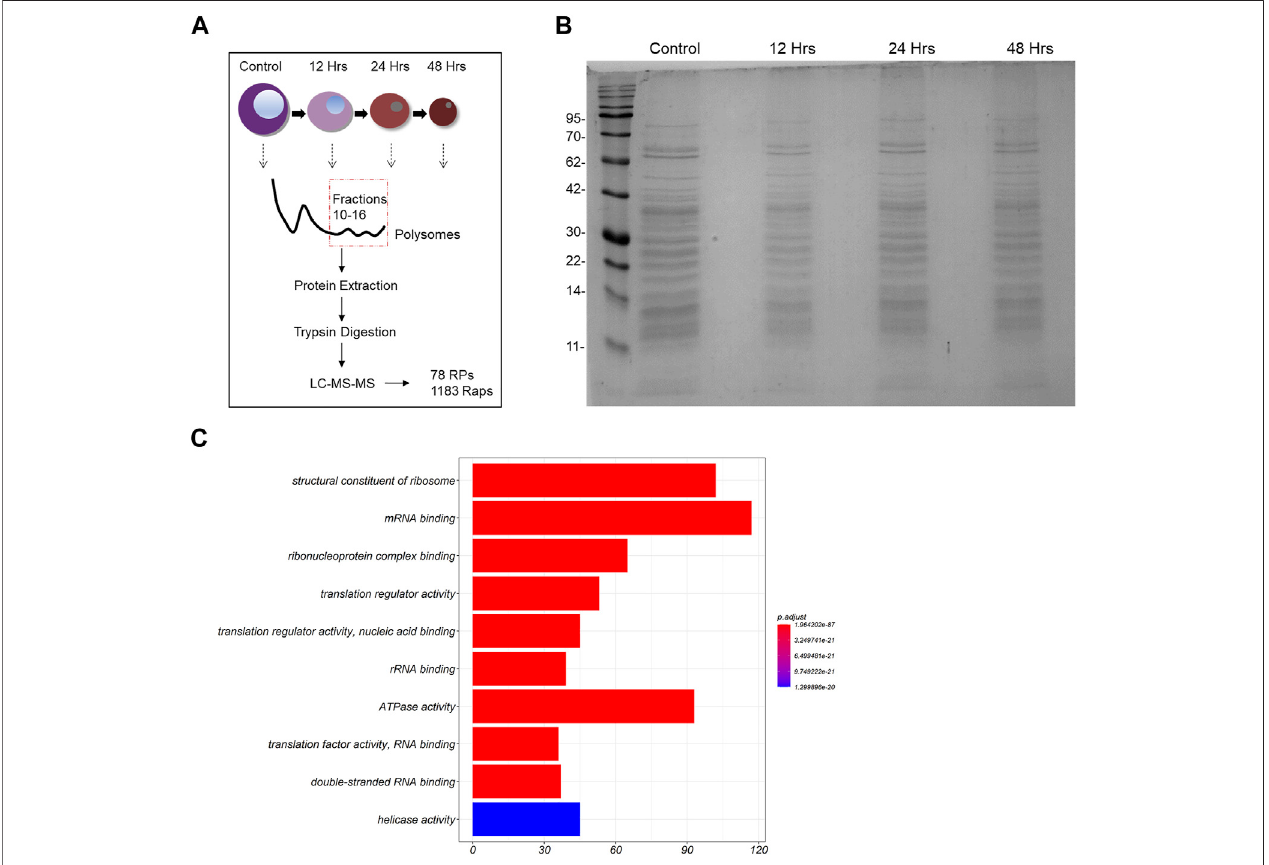
FIGURE 2 | Analysis of the riboproteome in MEL cells. (A) Design of the study. (B) Total protein material was extracted from pooled fractions 10 – 16 by protein fi ltration. The proteins were then loaded on an SDS-PAGE gel, stained with blue silver staining and depicted. (C) Gene ontology (GO) Molecular Function (MF) terms enriched inthe1261proteins(RPsandRaps) thatarepartoftheuntreated MELcells ’ ribo-proteome.Thetenmoststatisticallysigni fi cantterms(FDRadjusted p -value < 0.05) are shown in the barplot ( y -axis) along with the number associated proteins ( x -axis). The over-representation analysis was performed using clusterPro fi ler.